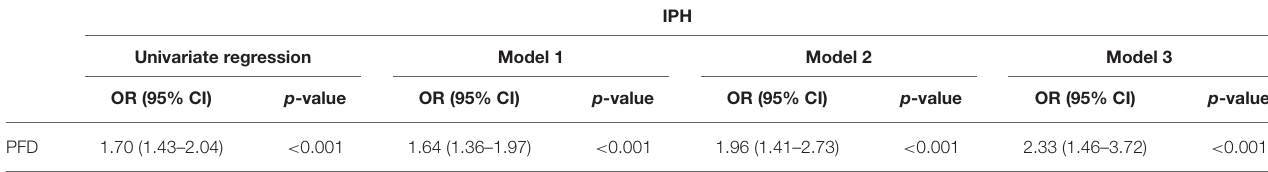
Model 1: adjusted for age. Model 2: adjusted for age, calcification, ulceration, degree of luminal stenosis, and maximum plaque thickness. Model 3: adjusted for BMI, hypertension, hyperlipidemia, diabetes, calcification, degree of stenosis, maximum plaque thickness, and ulceration. OR, odds ratio; CI, confidence interval; BMI, body mass index; PFD, pericarotid fat